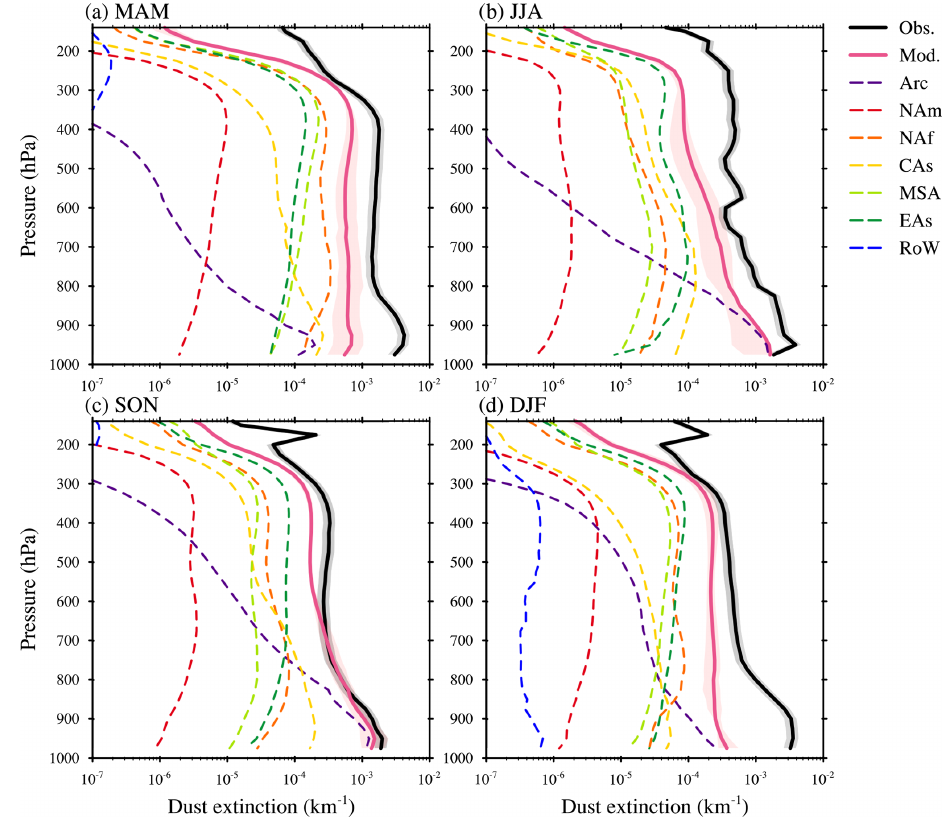
Figure 5. Comparison of seasonal CALIPSO-retrieved (Luo et al., 2015a, b; Yang et al., 2022) (black solid line; with gray shading repre- senting uncertainty) and model-simulated (pink solid line; with pink shading representing year-to-year variability) dust extinction vertical profiles in the Arctic (above 60 ◦ N). Contributions from seven tagged sources are shown by colored dashed lines. The CALIPSO retrievals are for the year 2007 to 2009, while the model results are averaged over the same years. The uncertainties of the CALIPSO retrievals are assumed to be 20% following Yang et al.